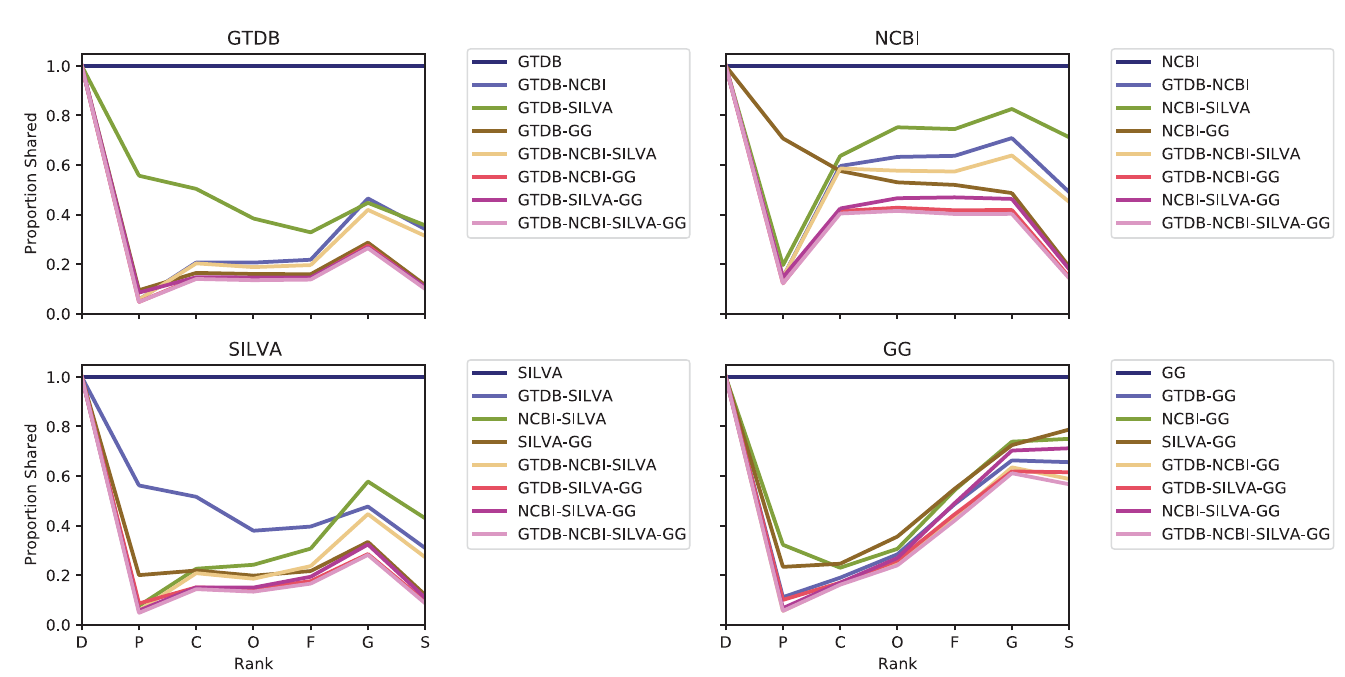
Fig 4. Comparison of taxonomic coverage among SILVA, Greengenes, GTDB, and NCBI-RefSeq 16S rRNA gene databases. Each panel displays the proportion of taxa represented in one reference database (as indicated in the panel title) that are shared with each other database at each taxonomic rank. The legends indicate which groups are being compared: the reference alone (always 1.0, shown for clarity), pairs consisting of the reference and one other database, trios consisting of the reference and two other databases, and the proportion of the reference’s labels that are shared by all four databases. Rank labels on x-axis: D = domain, P = phylum, C = class, O = order, F = family, G = genus, S =